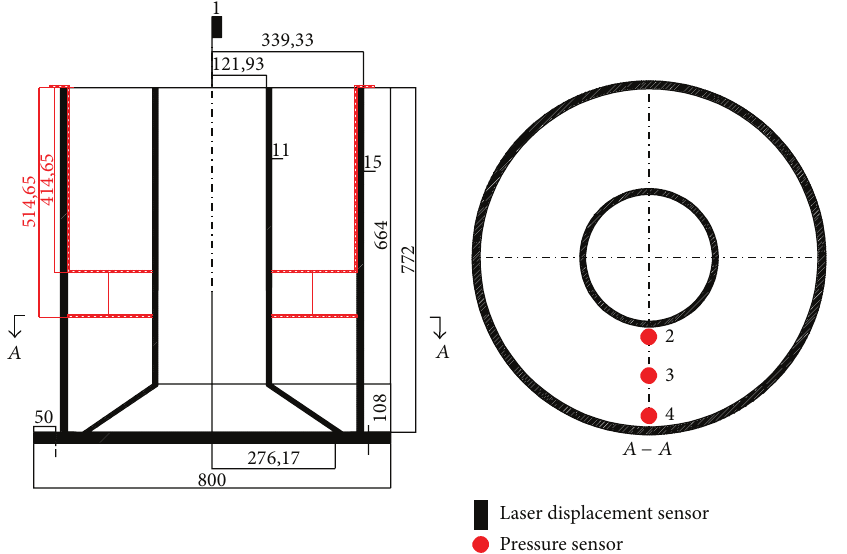
Figure 3: Sensor